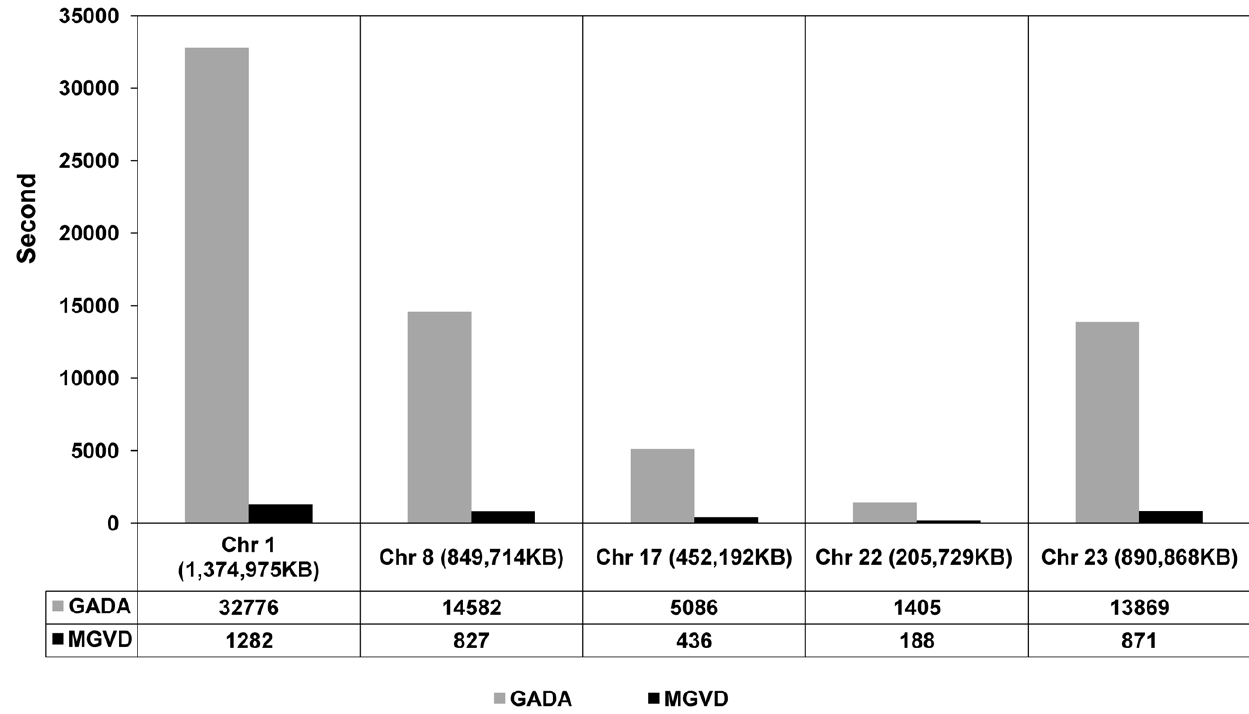
Figure 6. Comparison of the computational runtime of MGVD and GADA for five chromosomes. For each chromosome, data from 40 samples was available. We measured the total runtime with 40 samples for each chromosome. The runtimes of both MGVD and GADA increased linearly as the data size increased. For all five various sized chromosomes of various sizes, the MGVD runtimes were shorter than the GADA runtimes.